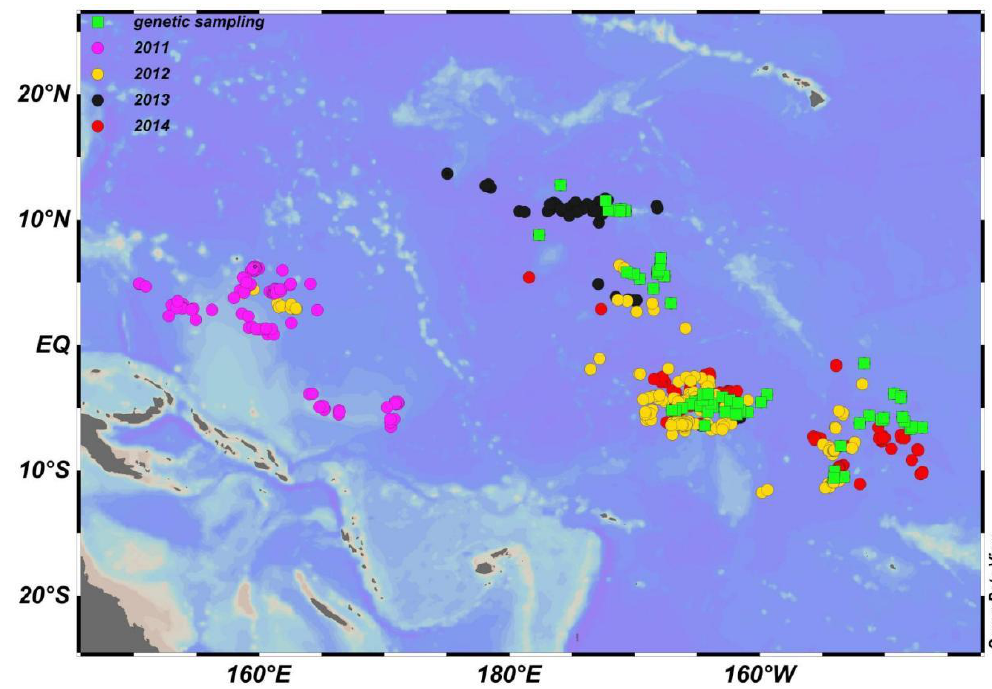
Figure 2. Geographic locations of the longline where onboard observers collected the data that was used in this paper.